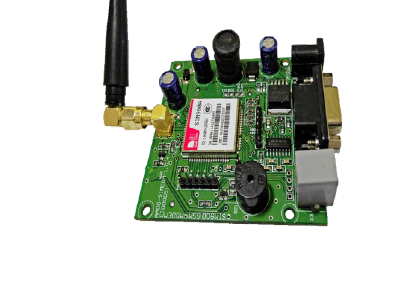
Figure 6. GSM Modem [21]